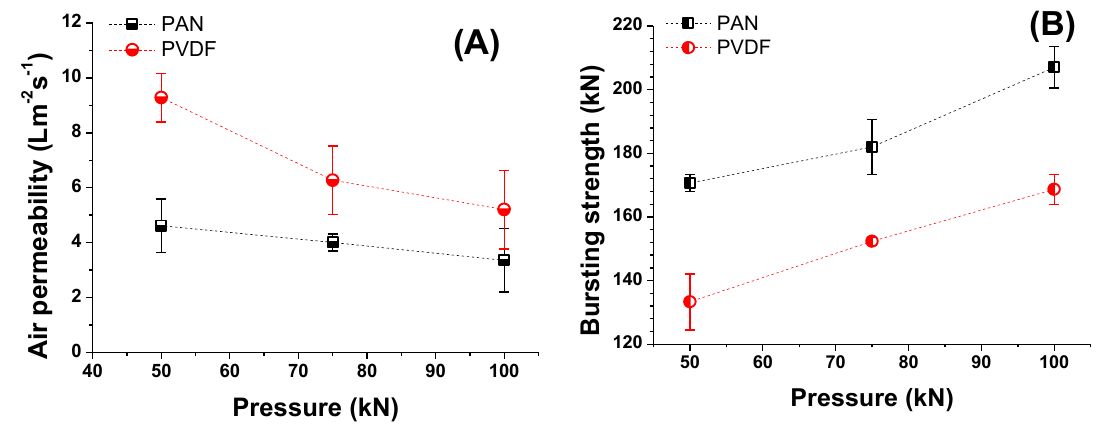
Figure 12. Influence of laminating pressure on ( A ) air permeability; and ( B ) bursting strength of multilayer nanofibrous membranes.